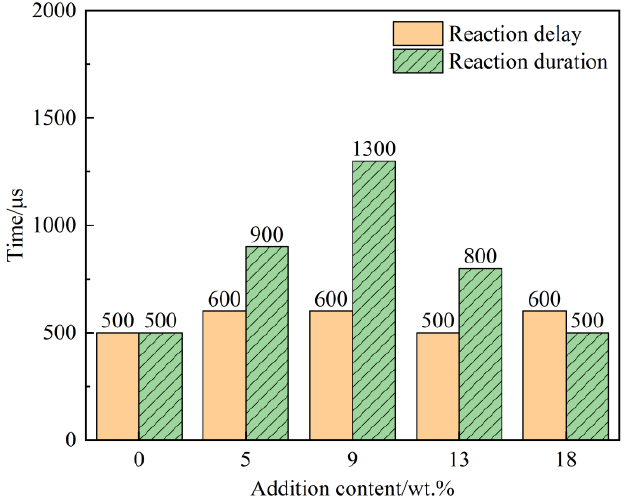
Figure 4. Shock-induced chemical reaction duration of PAB with different addition contents (height = 150 cm).